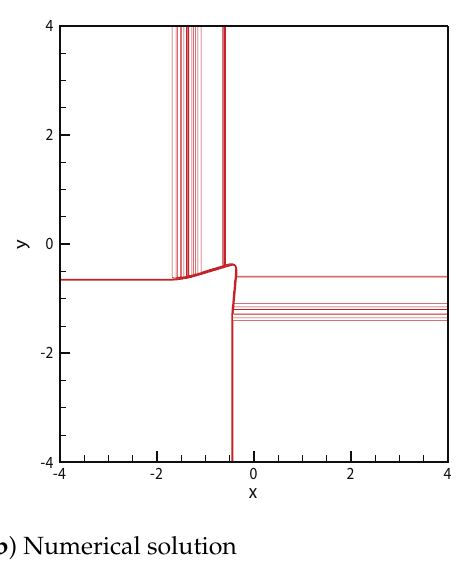
Figure 2. Case 2. JR + S δ + S δ + RJ . Case 3. R + S δ + S δ + R ( u 2 < u 4 < 0 < u 3 < u 1